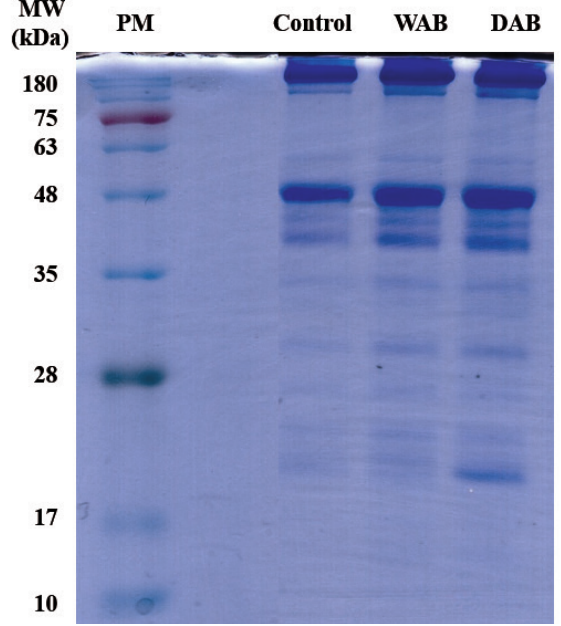
Figure 1. Sodium dodecyl sulfate-polyacrylamide gel electrophoresis patterns of aging methods on beef loin. Vertical numbers indicate molecular weight marker in kDa. PM, protein marker; Control, non-aged beef; WAB, wet-aged beef; DAB, dry-aged